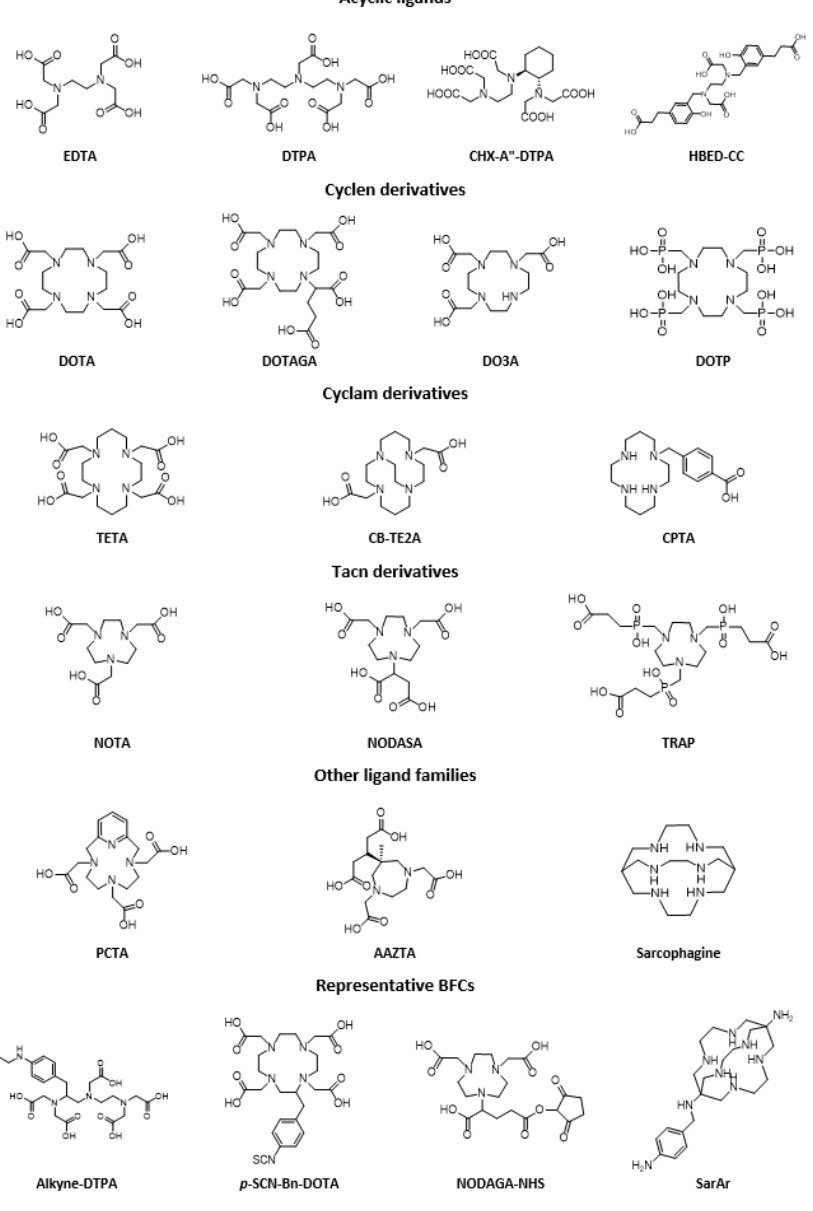
Figure 5. Representative (but not exhaustive) examples of acyclic and macrocyclic polyamino and polyaminocarboxylic chelator families and their derivatives.